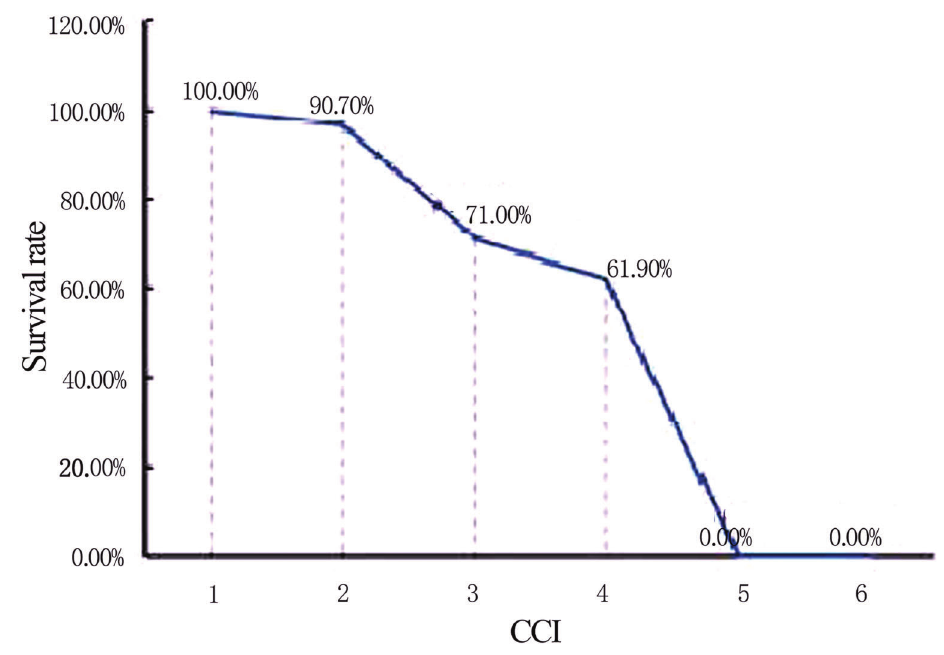
Figure 2. Comparison of 3-year survival rates of urgent-start peritoneal dialysis patients with different Charlson comorbidity index (CCI).